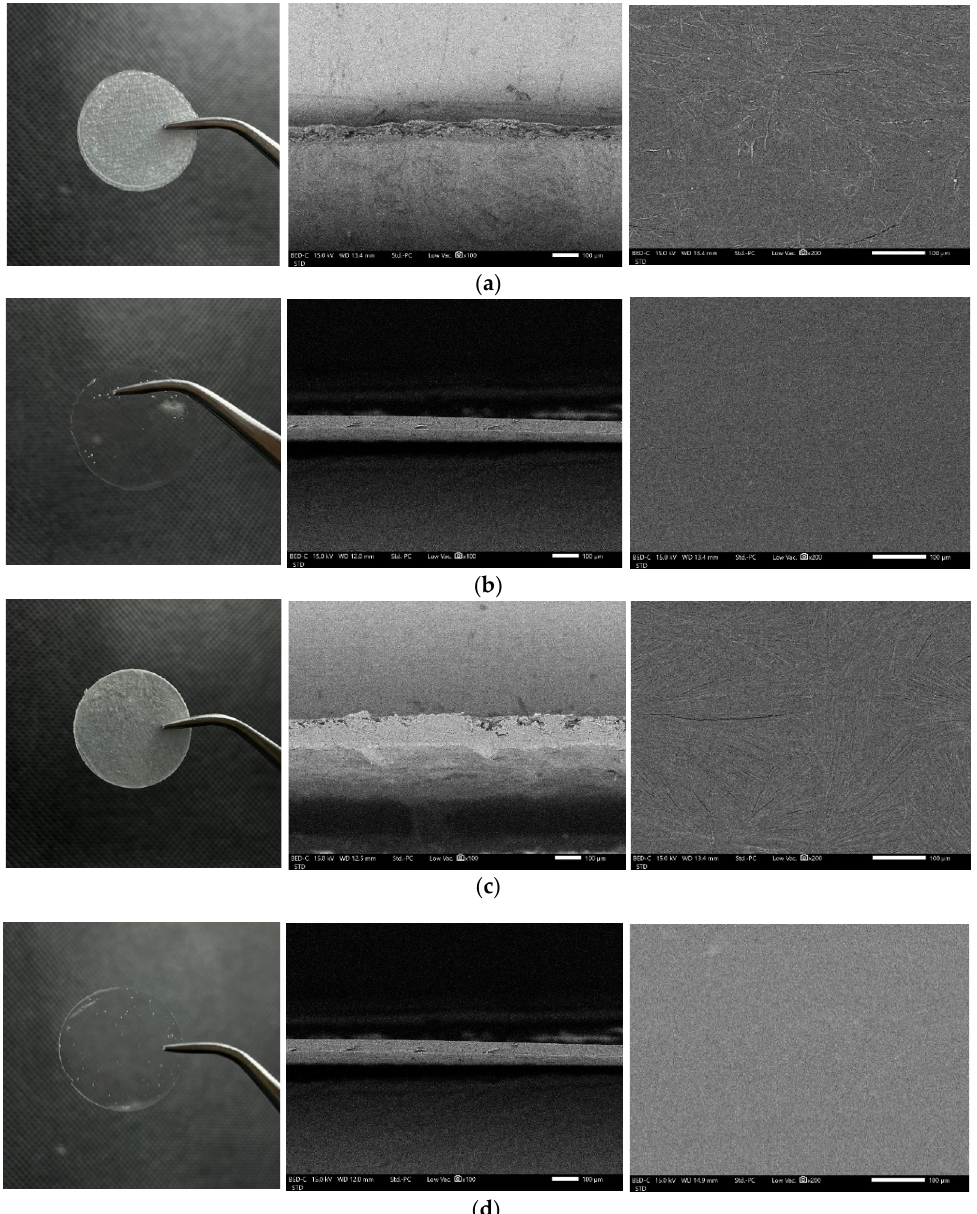
Figure 4. Visual appearances and SEM micrographs of 3D ‐ MTZ ( a ), 3D ‐ blank ( b ), C ‐ MTZ ( c ), and C ‐ blank ( d ).